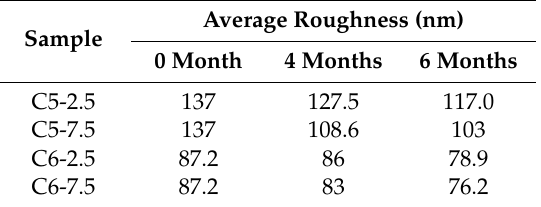
Table 3. The roughness of RO membranes before and after exposure to the acid solutions.